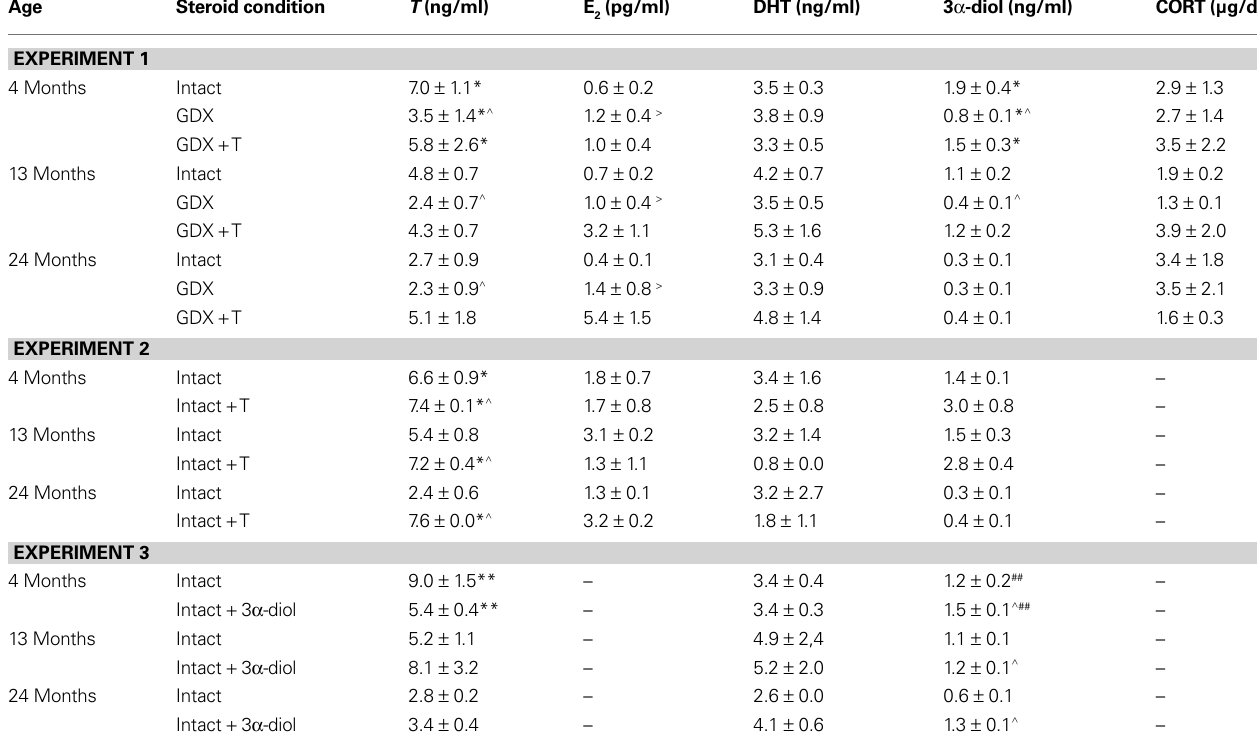
Table 4 | Plasma steroid levels of 4-, 13-, and 24-month-old gonadally-intact (intact), gonadectomized (GDX), or GDX and T-replaced (GDX + T; Experiment 1), intact or intact and T-administered (Experiment 2), and intact or intact and 3 α -diol administered (Experiment 3)